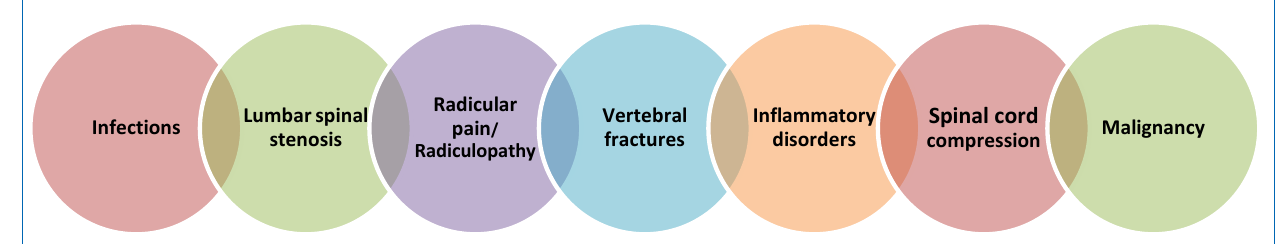
Figure 1: Pathological causes of back pain